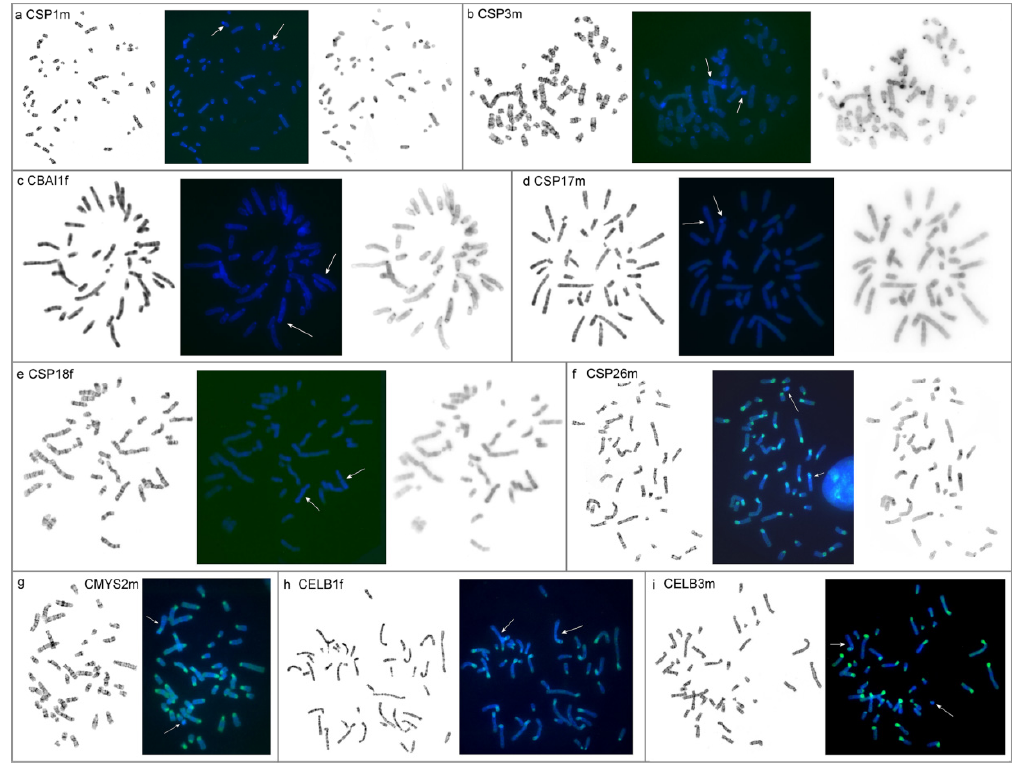
Figure 6. Results of CDAG: ( a ) Calomyscus sp. 1m (CSP1m); ( b ) Calomyscus sp. 3m (CSP3m); ( c ) C. bailwardi 1f (CBAI1f); ( d ) Calomyscus sp. 17m (CSP17m); ( e ) Calomyscus sp. 18f (CSP18f); ( f ) Calomyscus sp. 26m (CSP26m); ( g ) C. m. mystax 2m (CMYS2m); ( h ) C. elburzensis 1f (CELB1f); ( i ) C. elburzensis 3m (CELB3m). From left to right: G-banding, CDAG, inverted DAPI-banding (for some individuals). Blocks of AT-rich heterochromatin (blue) and blocks of GC-rich heterochromatin (green). Sex chromosomes marked by arrows.